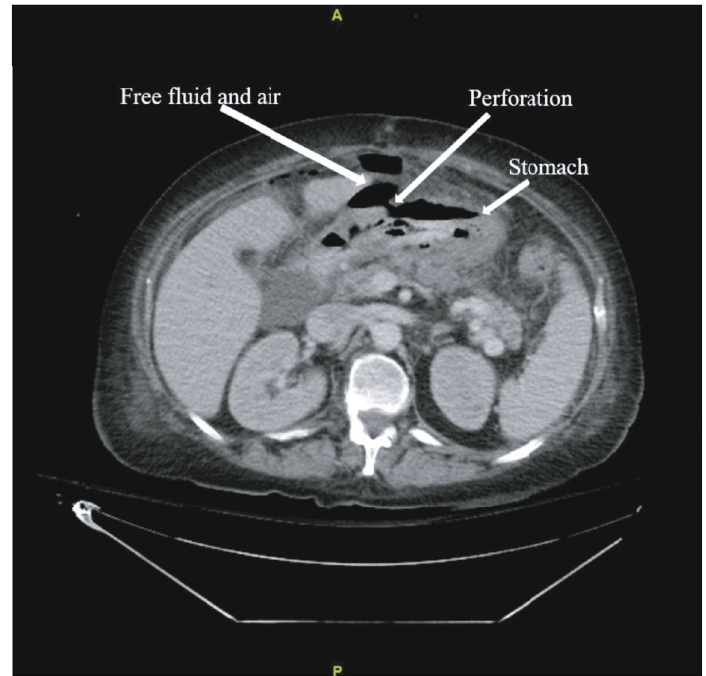
Figure 2: Patient 2 CT abdomen exhibiting bowel perforation secondary to mucormycosis.